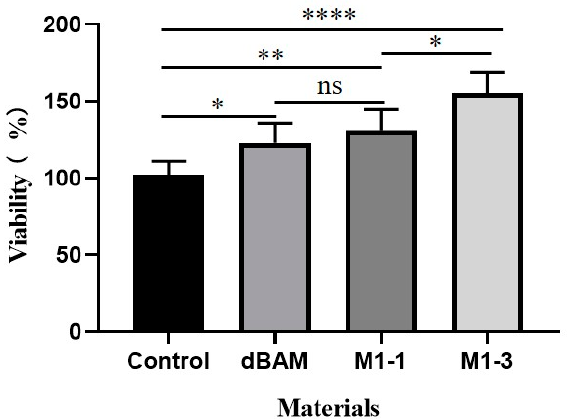
Figure 5. The biocompatibility test of dBAM, M1-1, and M1-3 (*: p < 0.05; **: p < 0.01; ****: p < 0.0001).